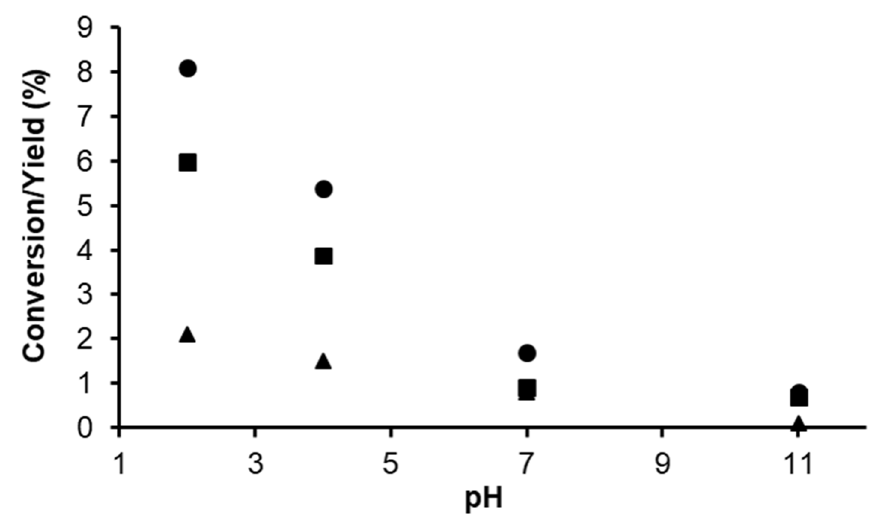
Figure 10. Conversion and product yields in hydrogenation of cinnamaldehyde catalyzed by 1 , as a function of the pH of the aqueous phase in water/toluene biphasic system ( • :total conversion; (cid:4) :cinnamyl alcohol; (cid:78) :3-phenylpropanal; o:3-phenylpropanol). Conditions: n(cinnamaldehyde) =